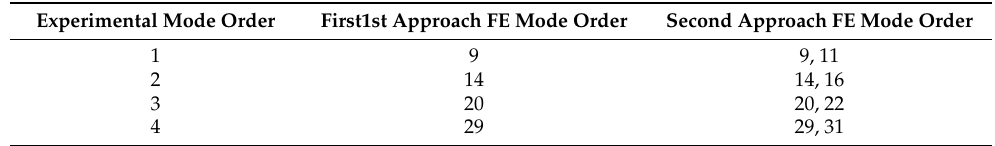
Table 9. Mode orders to be tracked in the two model-updating approaches.